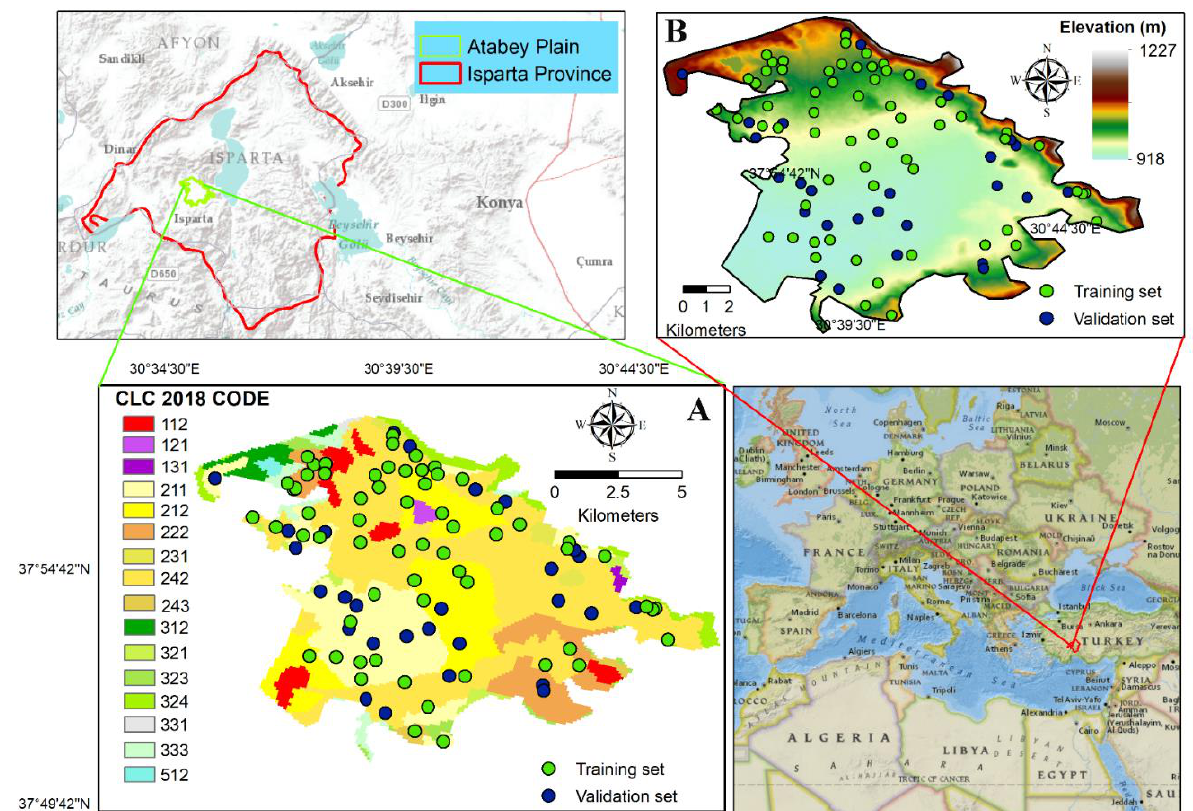
Figure 1. The location of the study area and the spatial distribution of the soil samples are overlaid on a CORINE 2018 land cover map ( A ) and DEM ( B ).